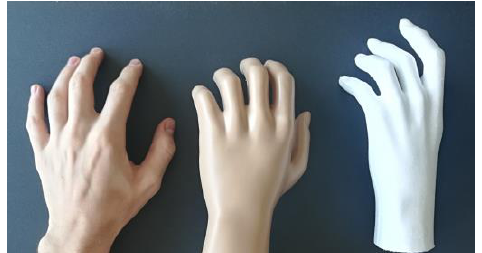
Figure 1. Tested white hand model on the right, compared to a real hand on the left and to the one of the mannequin in the middle.